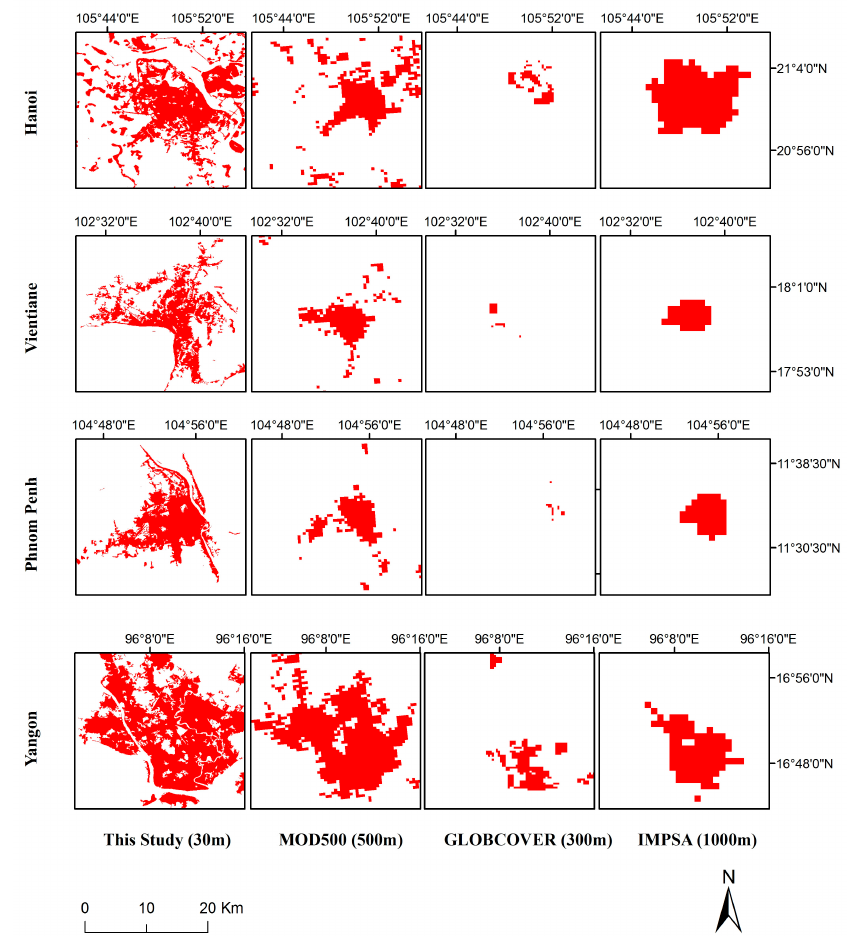
Figure 9. Comparison of the 30-m resolution built-up areas developed in this study with three coarse resolution urban built-up maps: the 2010 MODIS-500 at 500-m resolution, the 2009 GLOBC-300 at 300-m resolution and the 2010 IMPSA-1000 at 1000-m resolution.